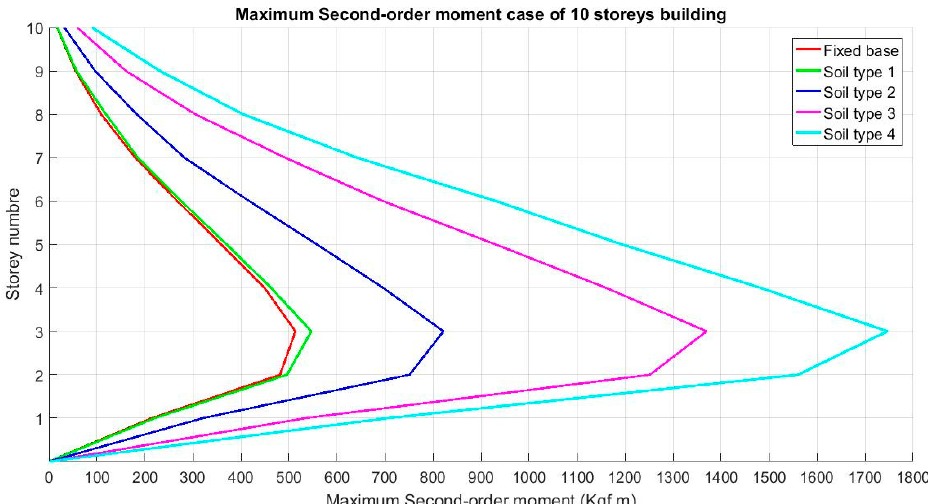
Figure 13. Maximum second-order moment case of a 10-story